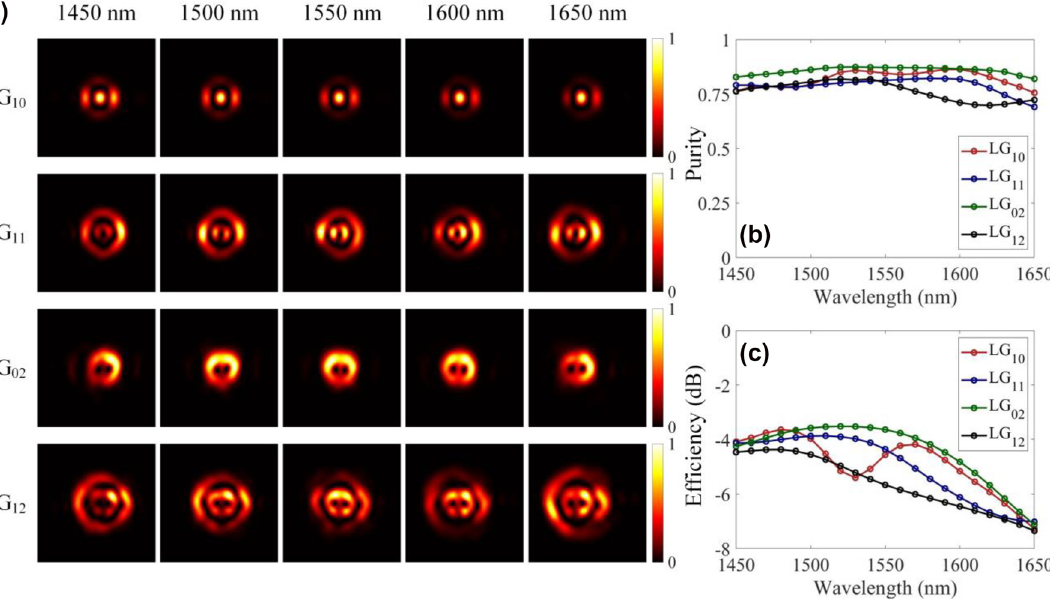
Figure 3: Broadband operation of the proposed LG beam generator. (a) The simulated normalized electric field intensity distribution of the generated LG beams for different topological charge l and radial node m at different wavelengths. (b, c) The simulated mode purity and emitting efficiency of the generated LG modes versus the